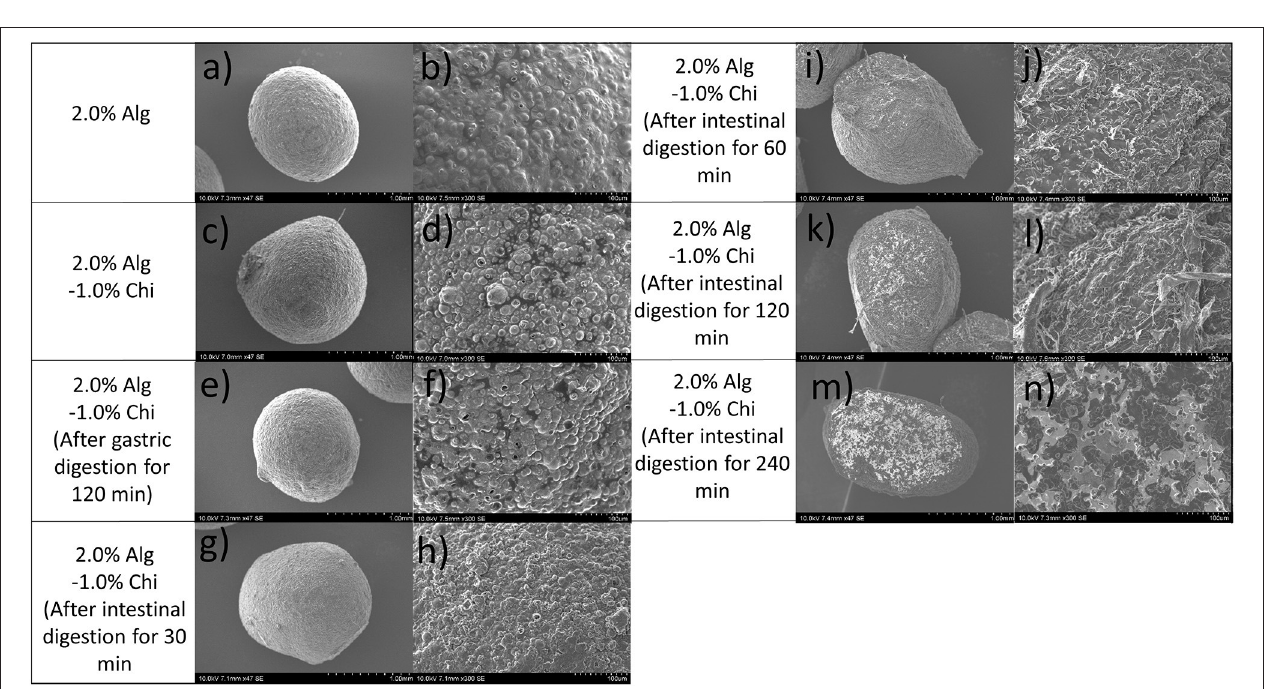
to around 100 and 85% after 240 min of intestinal digestion for Alg-TPE and Alg-Chi-TPE hydrogel beads,